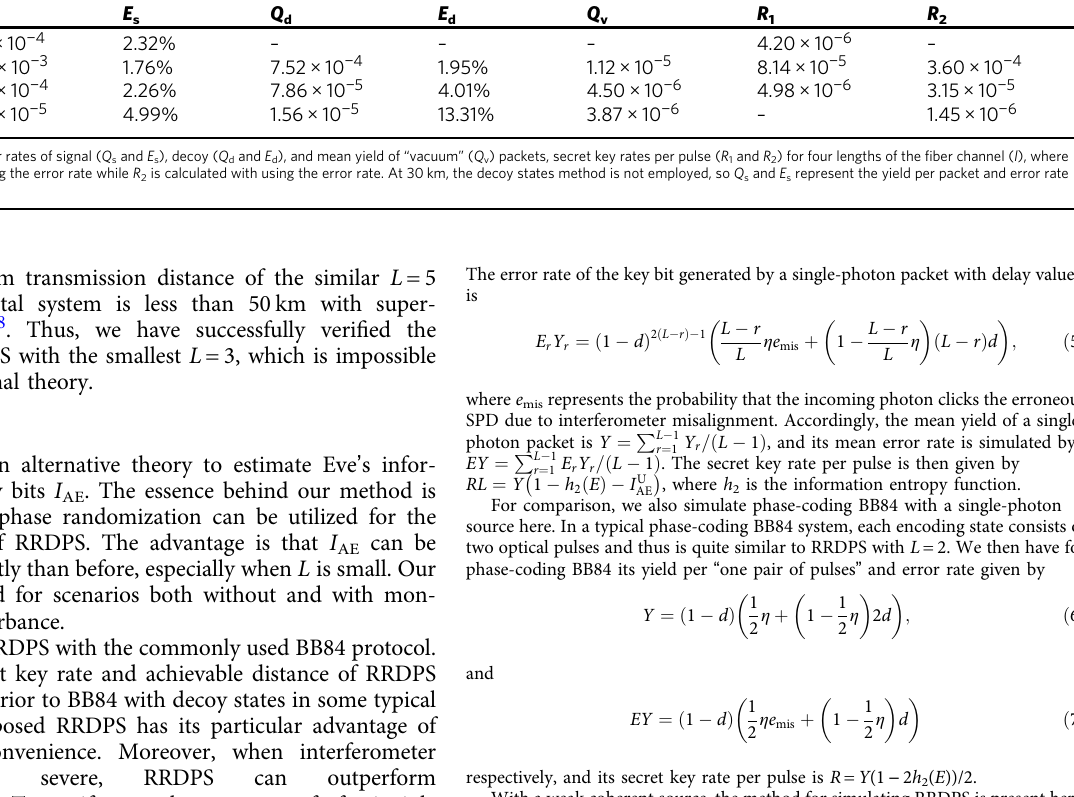
Table 3 Experimental results of the L = 3 RRDPS system